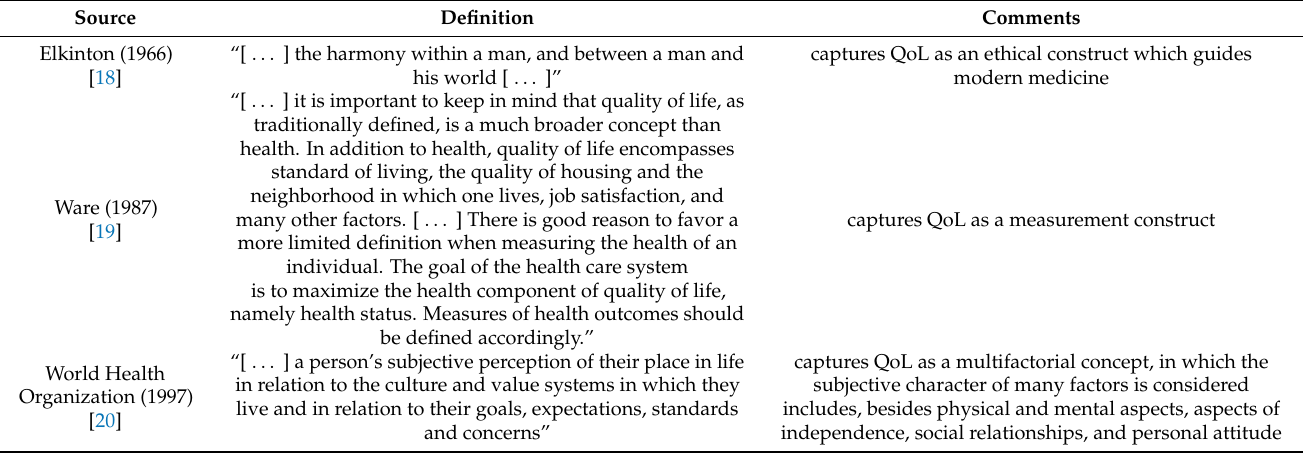
Table 1. Key conceptualizations of QoL over the course of the last